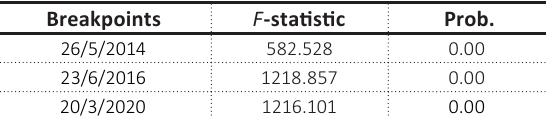
Table 1. Chow test